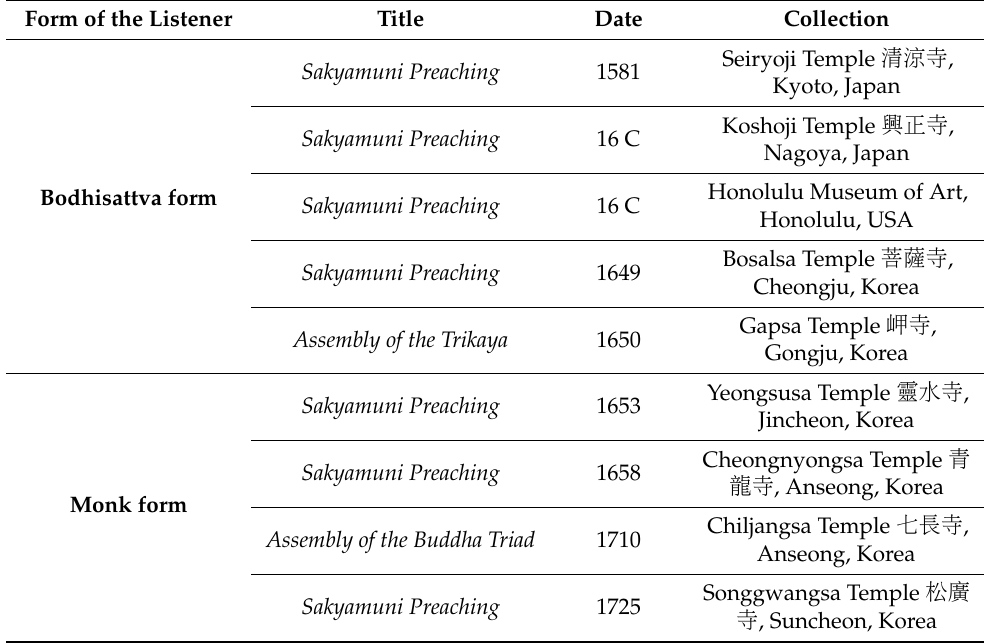
Table 1. Joseon Sakyamuni Preaching paintings featuring the Listener. Form of the Listener